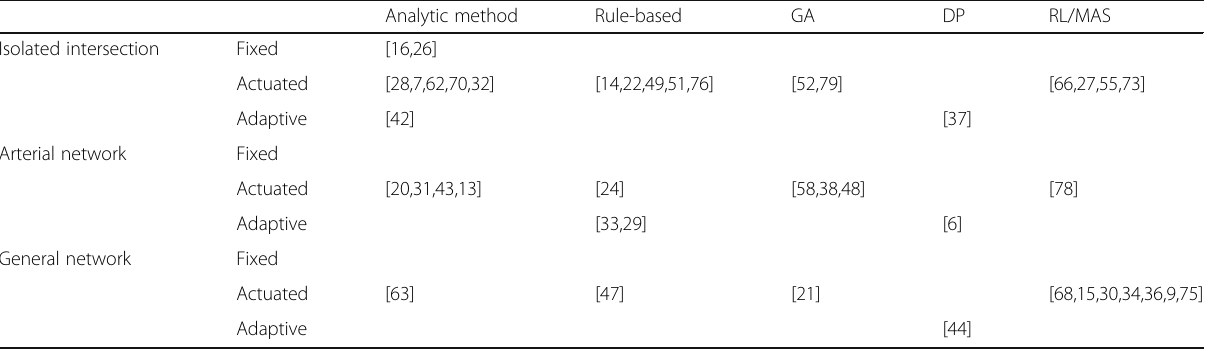
Table 6 Literature summary based on solution methods and problem